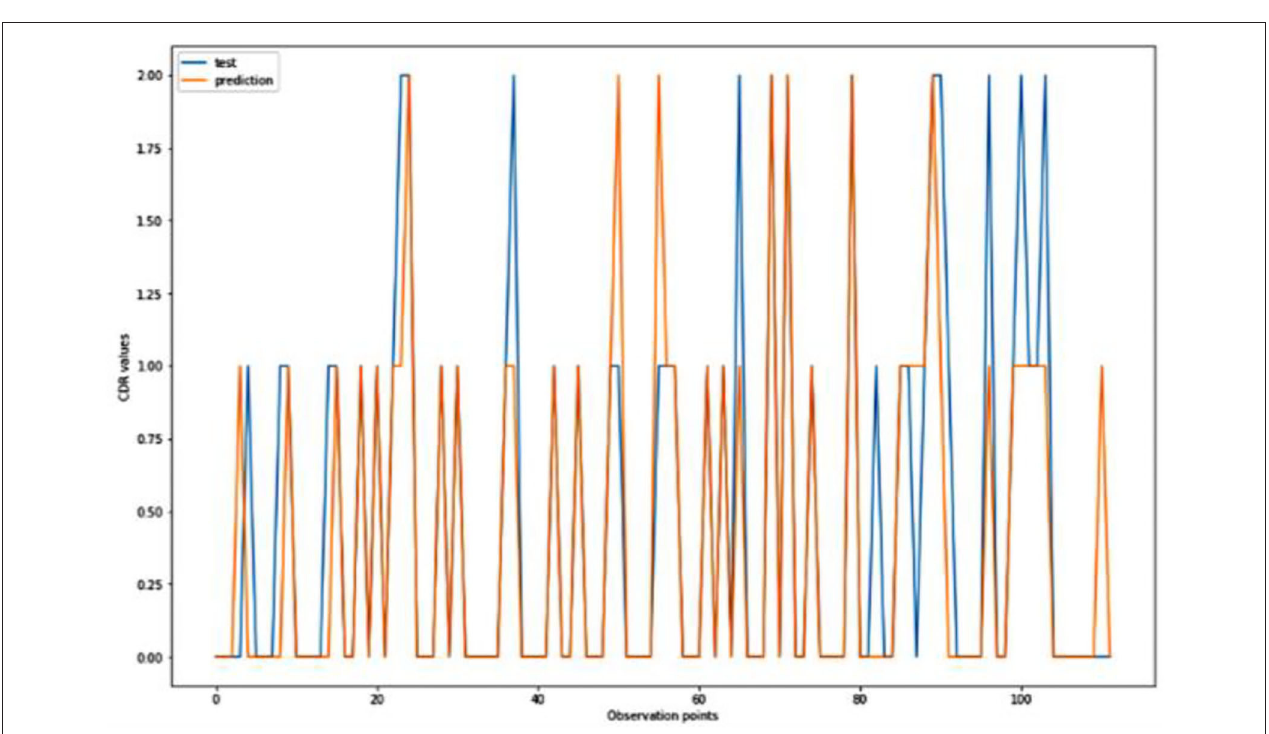
FIGURE 6 | Graphical representation of the comparison of test and predicted CDR values obtained using the logistic algorithm. (11 parameters).